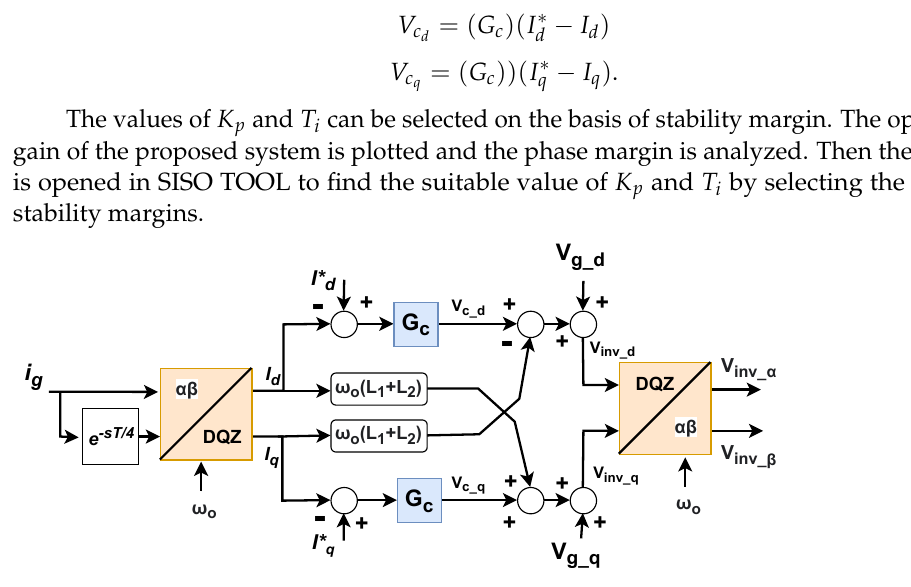
Figure 9. Block diagram of synchronous framed current